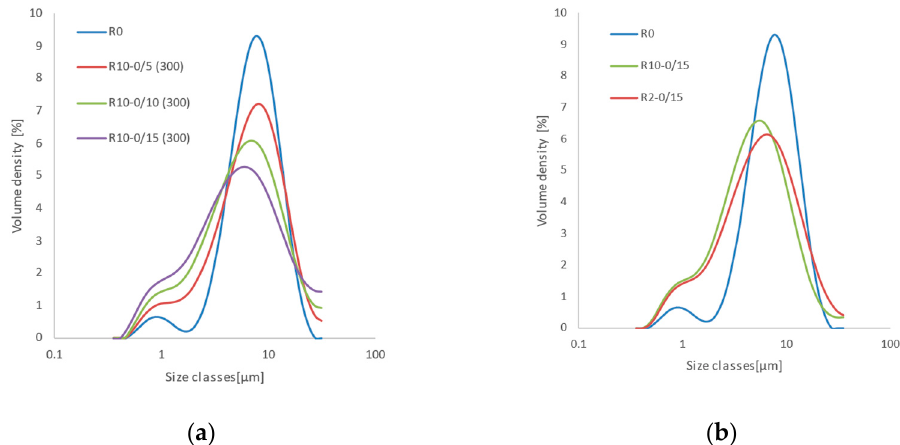
Figure 1. Particle size distribution of reference meloxicam and milled reference samples varied according to the diameter of the grinding balls, grinding time, and rotation speed of the mill: ( a ) 10 mm balls, 5–15 min, 300 rpm; ( b ) 2 mm and 10 mm balls, 15 min, 100 rpm.